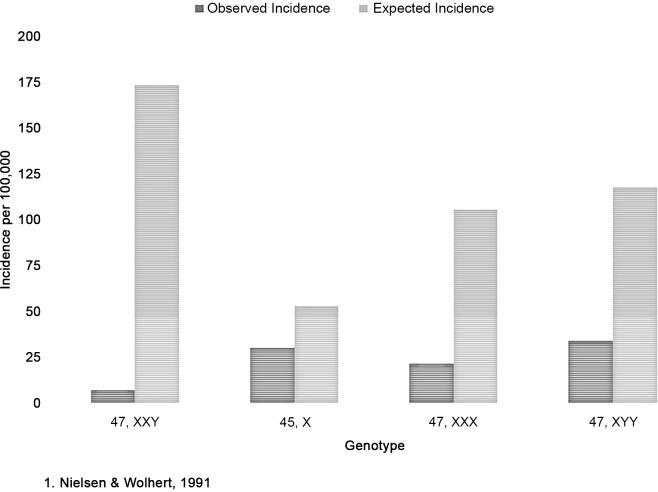
Incidence of X and Y chromosomal aneuploidy compared to previous studies.